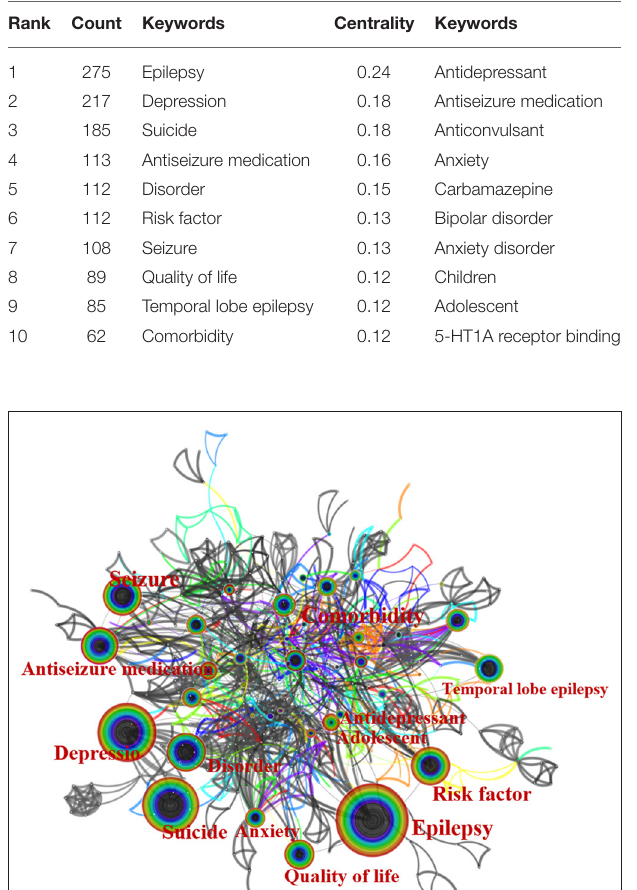
TABLE 4 | The top 10 keywords of epilepsy with suicide.